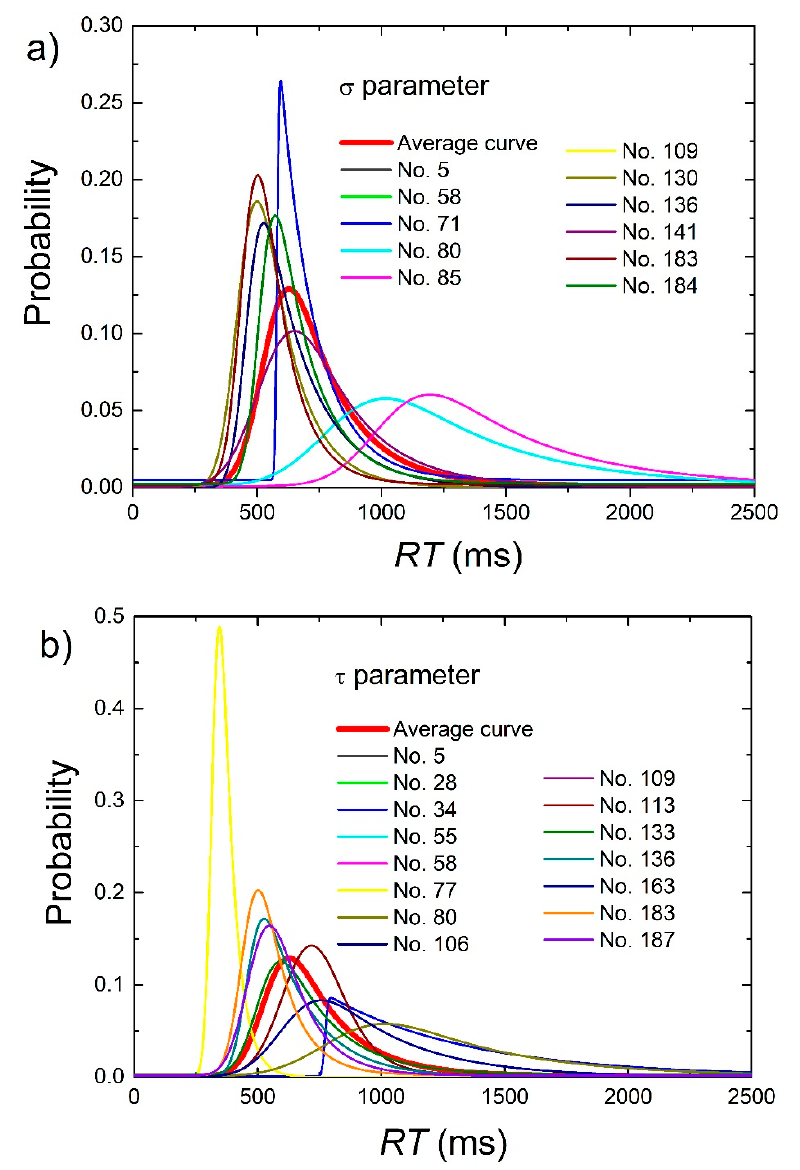
Figure 8. Probability distributions of the candidates resulting from the probability distribution of σ ( a ) and τ ( b ) parameters of the ex-Gaussian probability density. The average curve has also been included.